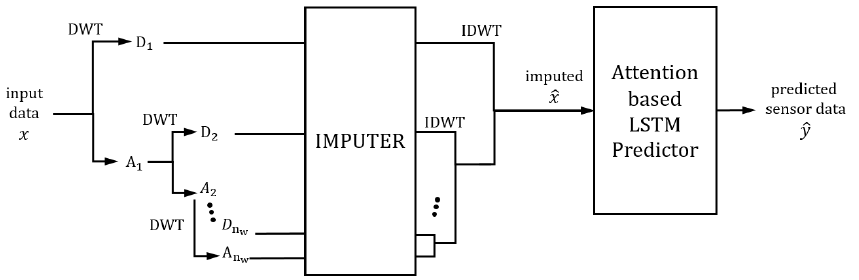
Figure 6. The architecture of the proposed network.